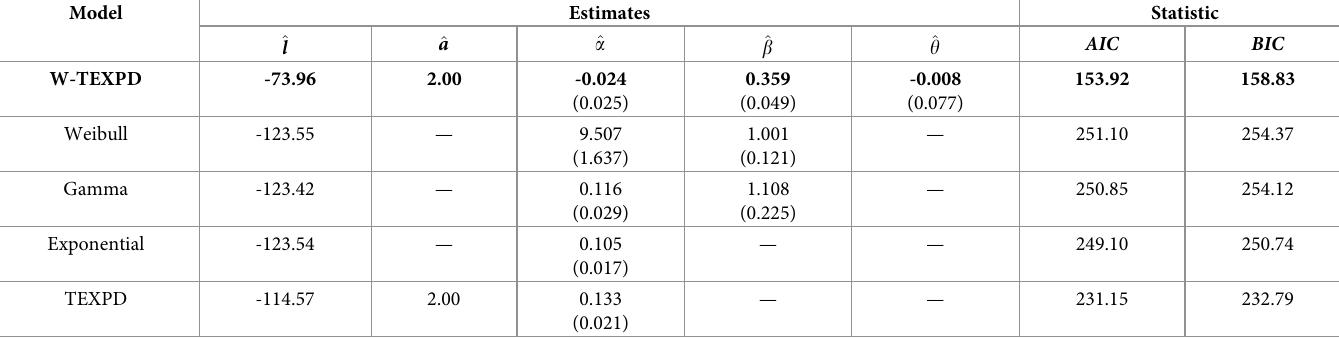
Table 15. Negative log-likelihood values ( ^ ‘ ), MLEs of model parameters, the corresponding SEs (given in parentheses)along with the AIC and BIC values for 40 losses due to wind-related catastrophes.